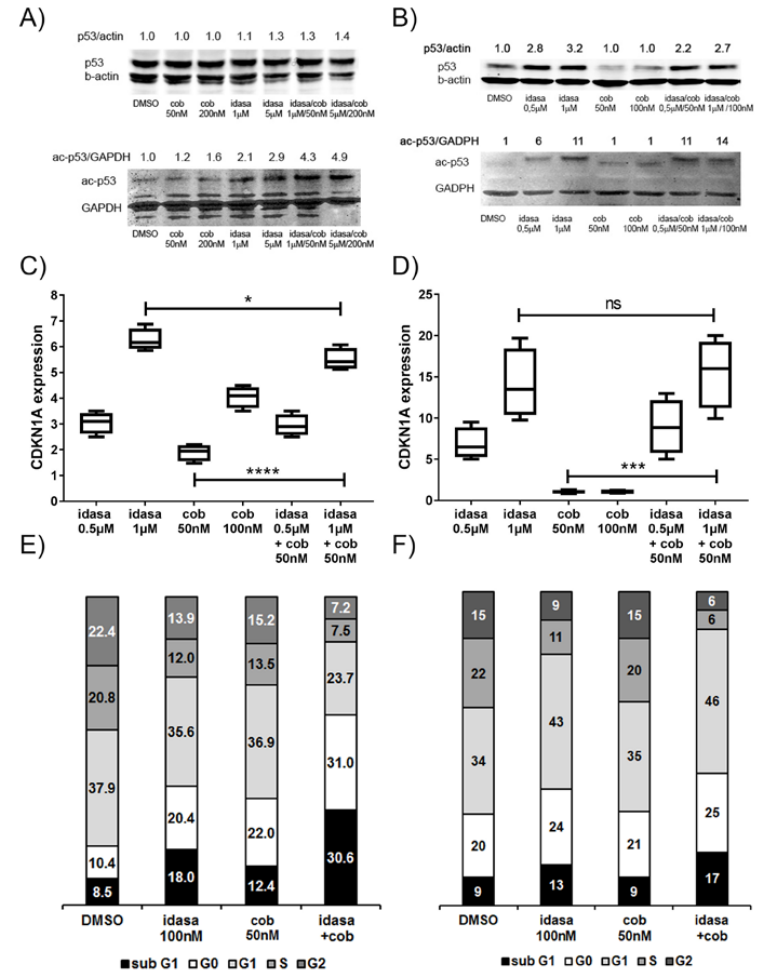
Figure 2. Induction of cell cycle arrest, cell cycle exit and cell death in AML cells treated with idasanutlin and cobimetinib. Induction of tumor suppressor protein p53 in OCI-AML2 ( A ) and MOLM-13 cells ( B ) treated for 24 h with the indicated amounts of idasanutlin and cobimetinib. Induction of the cell cycle inhibitor CDKN1A gene in OCI-AML2 ( C ) and MOLM-13 cells ( D ). Relative quantitation of CDKN1A mRNA normalized to GAPDH . Data are presented as fold induction of treated versus untreated, with CDKN1A expression in DMSO treated cells = 1. Induction of cell cycle arrest, cell cycle exit and cell death in the AML cell lines OCI-AML2 ( E ) and MOLM-13 ( F ) treated for 24 h with single compounds or with combination treatment. Cells were grouped into defined cell cycle phases by DNA content and Ki-67 expression levels with subG1 (<2n), G0 (2n, Ki67 low), G1 (2n,